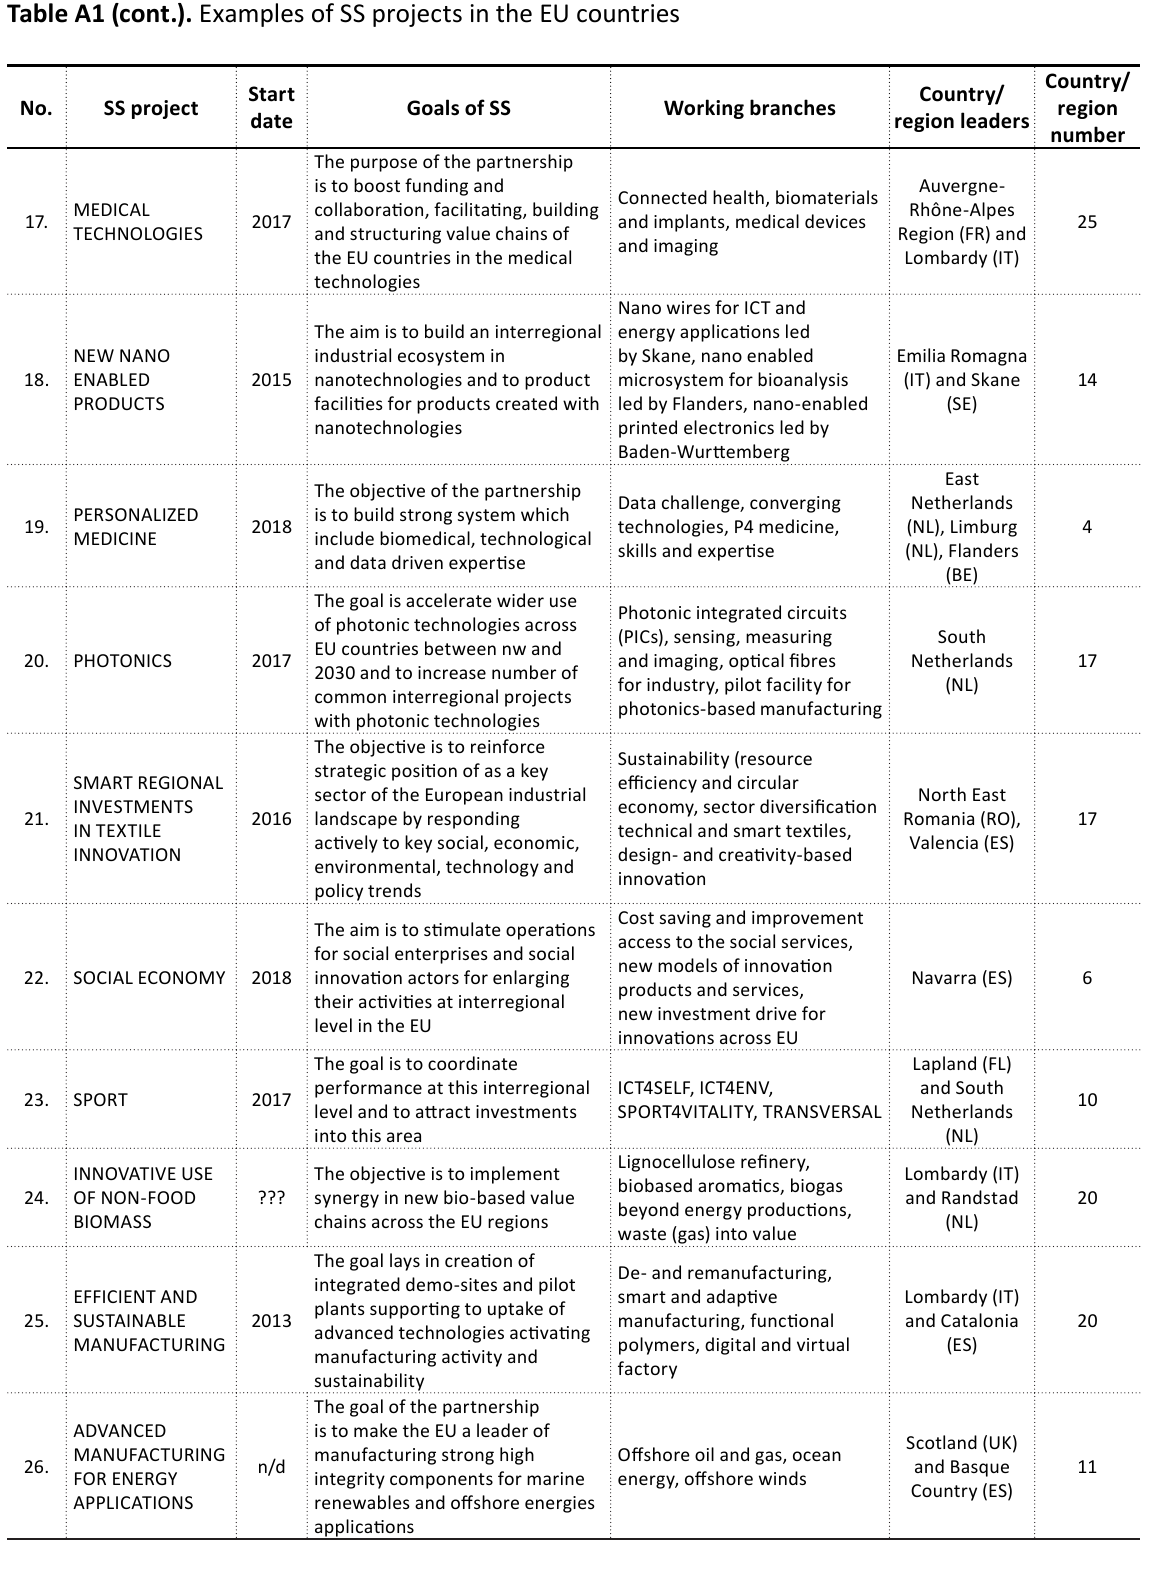
Table A1 (cont.). Examples of SS projects in the EU